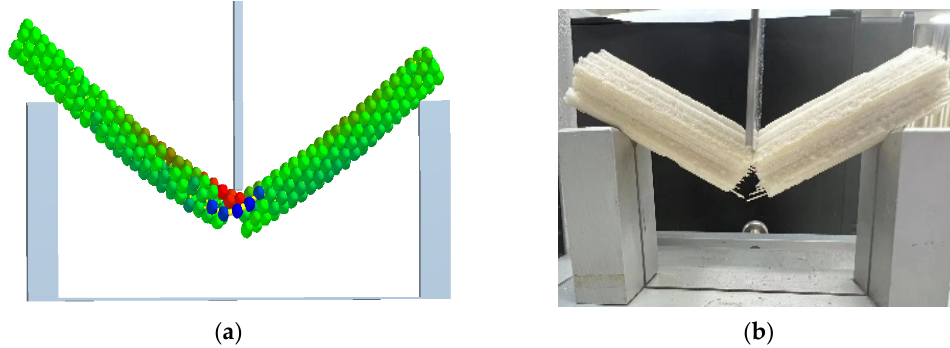
Table 8. Analysis of variance of quadratic regression model of internal flesh bending damage force response surface.